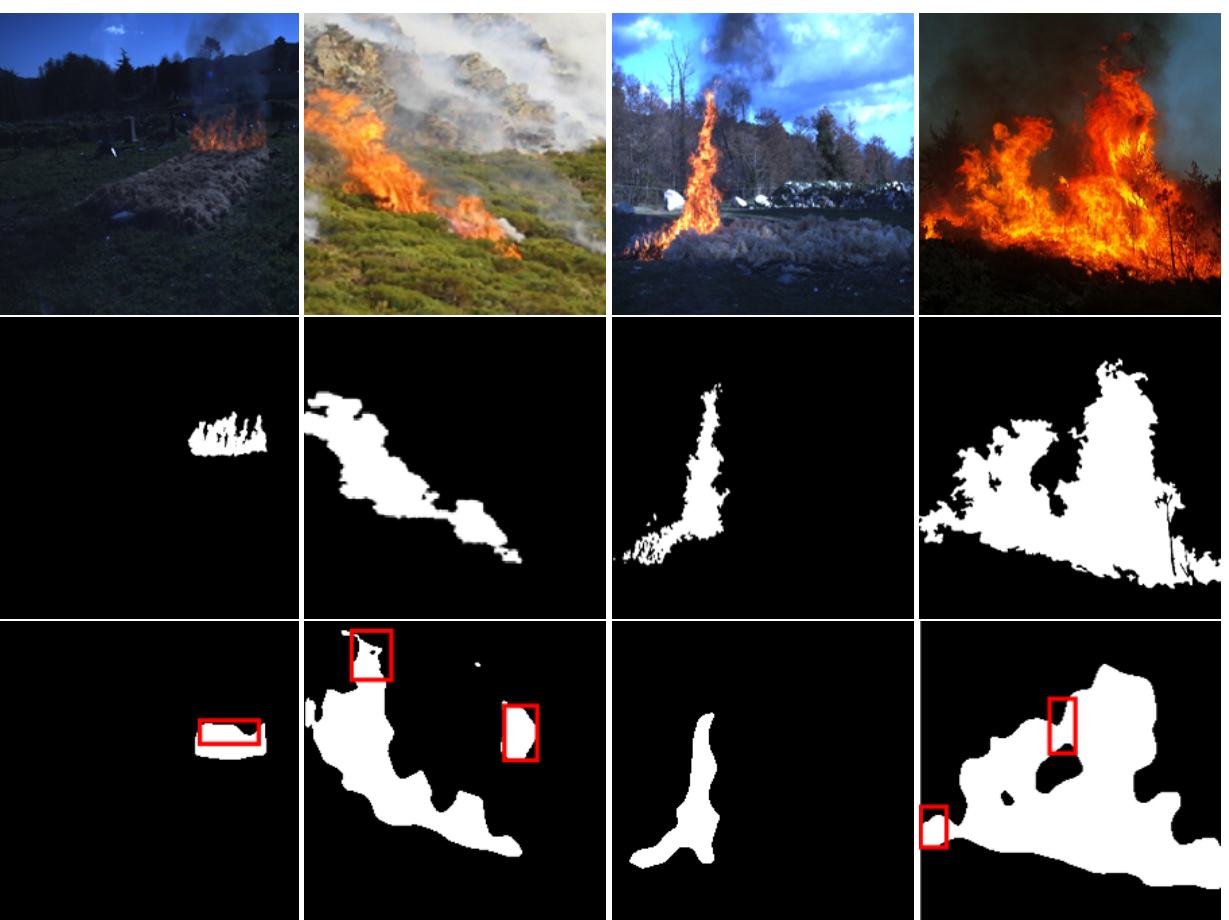
Figure 7. Results of TransUNet-ViT. From ( top ) to ( bottom ): RGB images, their corresponding mask, and the predicted images of